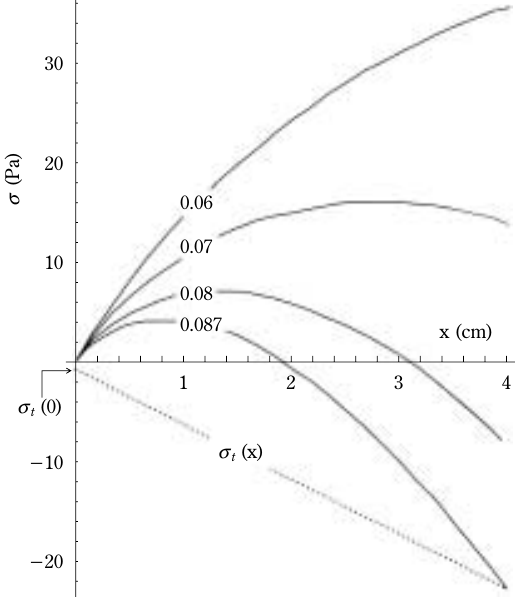
Fig. 5 Continuous lines: Uniaxial tension ( s ) across a non-homo- geneous bed of powder as the gas flow is increased (the ratio of the gas velocity to the sedimentation velocity of an individual particle v g / v p 0 is indicated for each curve). The free surface is at x (cid:2) 0 and the bottom at x (cid:2) 4 cm. The cal- culation is performed for a non-homogeneous bed with average particle volume fraction (cid:2) f (cid:3) (cid:2) 1.366 (cid:7) 1.088/(1 (cid:3) 3.968 x ) 0.02454 (fit curve to Canon CLC500 toner experimen- tal data) and particle density r p (cid:2) 1199 kg/m 3 . The dotted line is the experimental tensile yield stress ( s t (cid:2) 1 (cid:3) 5.5 x Pa) for Canon CLC500. The yield condition ( s (cid:2) s t ) is met at the bottom of the powder ( x (cid:2) 4 cm) for v g / v p 0 (cid:8) 0.087.